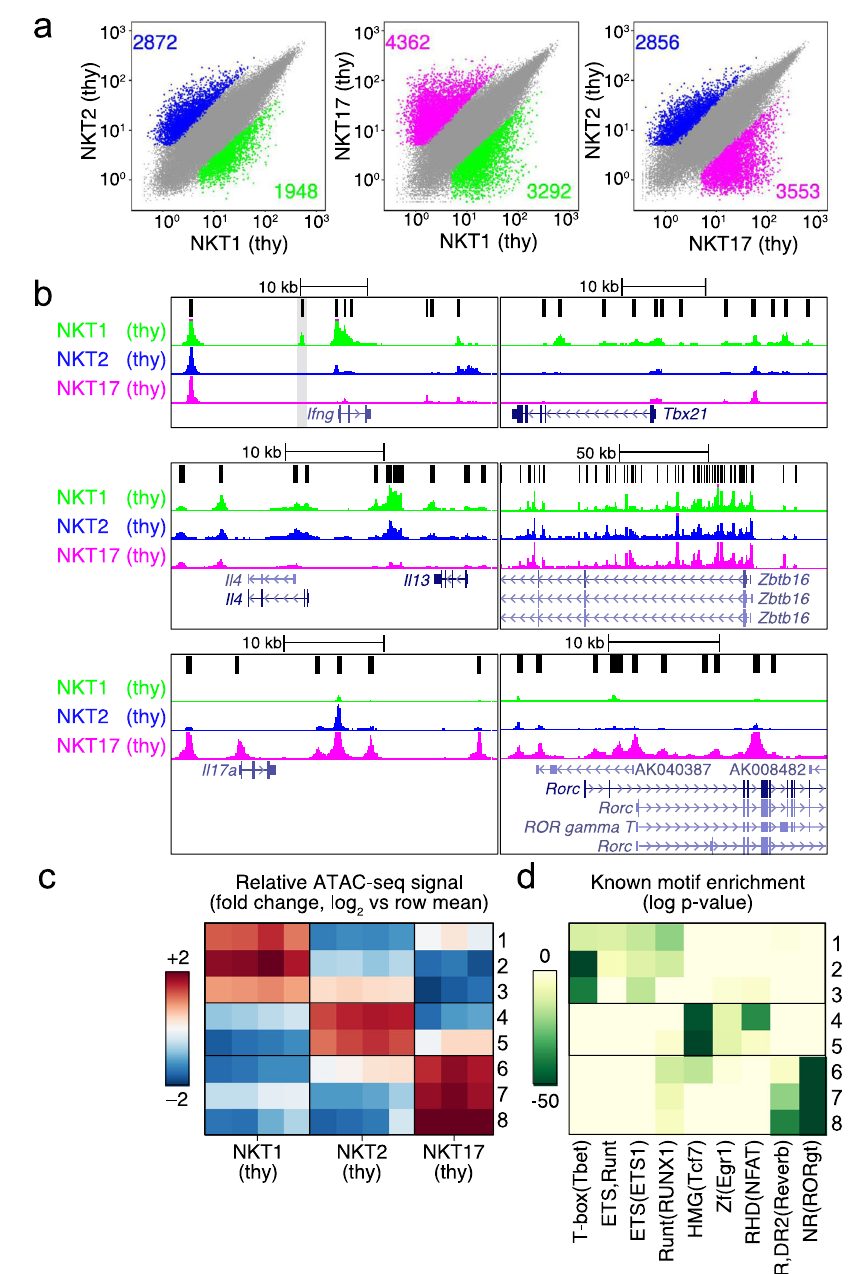
Fig. 1 Subsets of thymic iNKT cells have differences in chromatin accessibility. a Scatterplot of mean ATAC-seq counts per peak comparing differentially accessible regions of chromatin for pairs of thymic iNKT cell subsets. Colors indicate differentially accessible regions de fi ned by limma/voom (details in ‘ Methods ’ ). Blue = enriched in NKT2, green = enriched in NKT1, purple = enriched in NKT17. Thymus = thy. The numbers of differentially expressed genes are indicated. b ATAC-seq coverage at the indicated gene loci with a range of 0 – 600 for all samples. Gray bar in the upper left panel ( Ifng ) locus indicates the enhancer region. c Left, k -means clustering of relative ATAC-seq density (counts per million mapped reads/kb, log 2 fold change from the mean) identi fi es eight groups of accessible regions that varied similarly (rows), 3 sets for NKT1, 2 for NKT2, and 3 for NKT17. Columns indicate the number of replicates, 3 or 4. d Motifs enriched in clusters of accessible regions. All motifs with a HOMER log p value less than – 15 using a cumulative binomial test and found in 10% or more regions in at least one cluster are